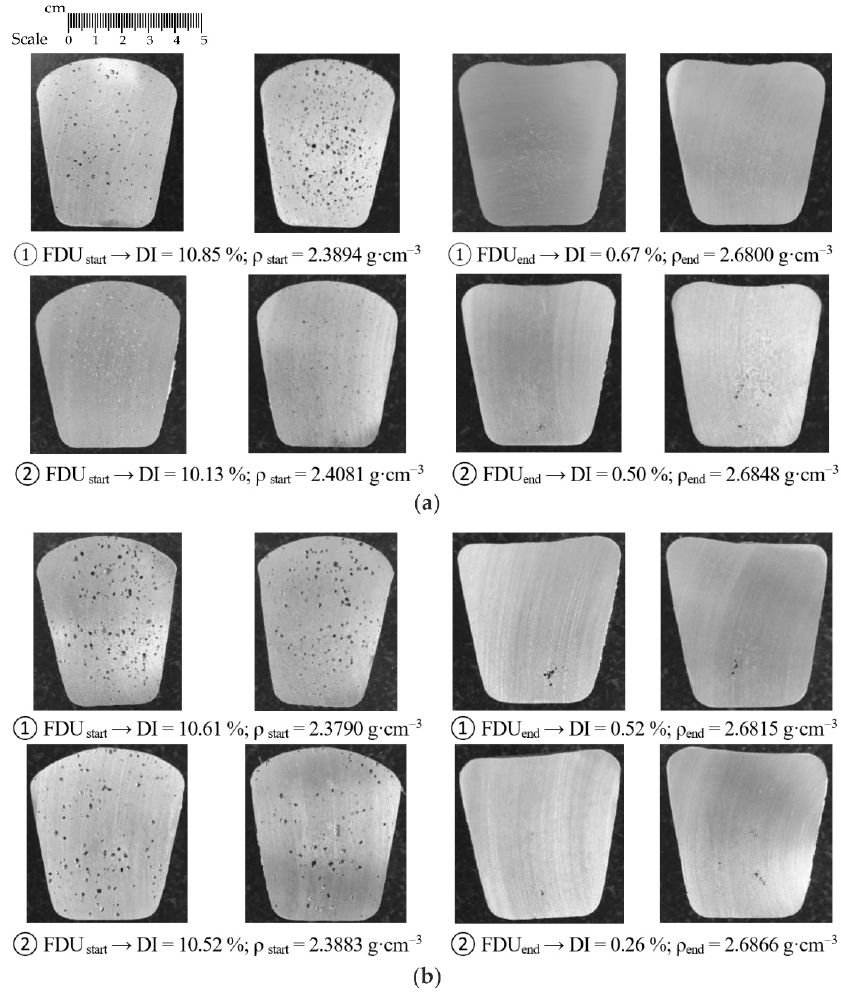
Figure 7. Sections of samples taken for gasification assessment for rotor A3: ( a ) wear 0% (series 1/VT); ( b ) wear 25% (series 2/VT).